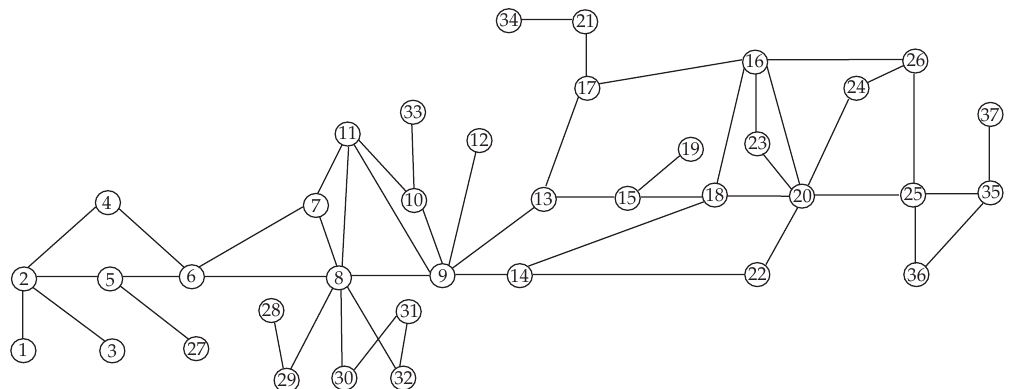
Figure 4: Local structures for all databases.